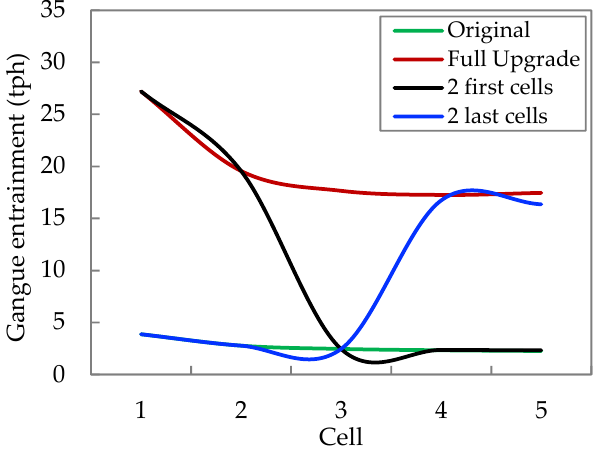
Figure 11. Gangue entrainment along the bank for the four scenarios. Table 2. Froth water recovery along the bank for the four scenarios.